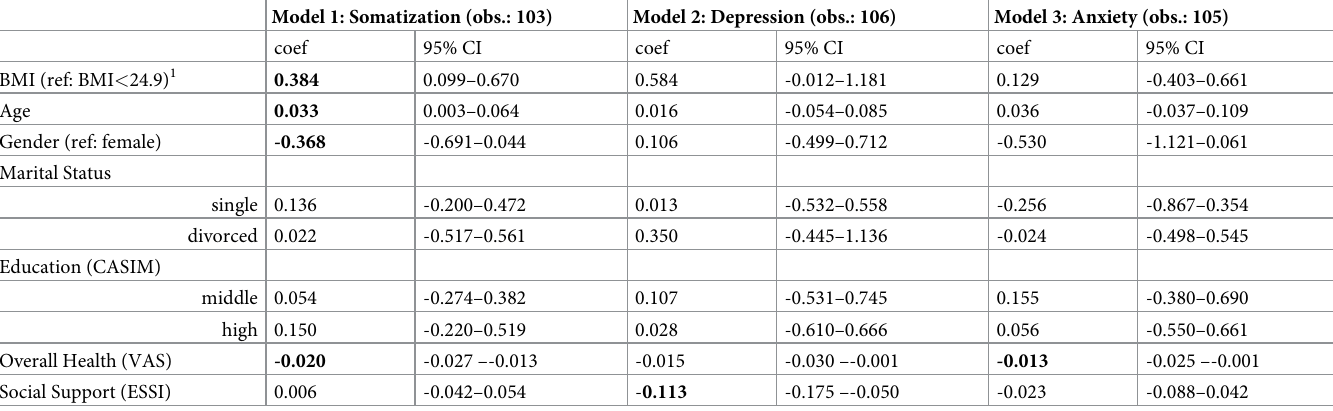
Table 2. Generalized logistic regression models with three dimensions of psychological health as outcome variables. Model 1: Somatization (obs.: